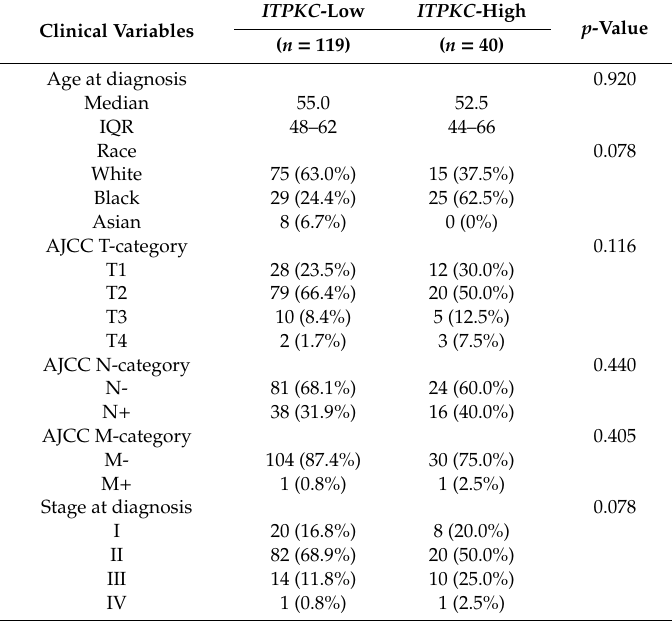
Table 1. Clinical characteristics of low and high ITPKC expression in TNBC patients in the TCGA cohort. ITPKC -Low ITPKC -High p -Value Clinical Variables ( n = 119) ( n = 40) Age at diagnosis